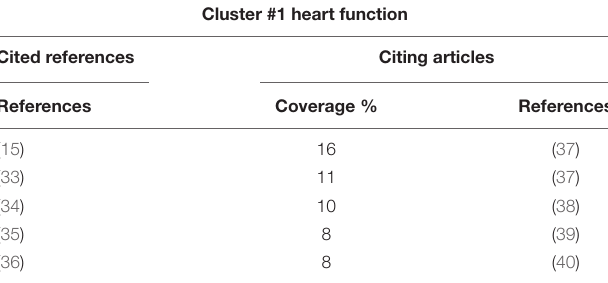
TABLE 4 | Cited references and citing articles of Cluster #1 heart function.